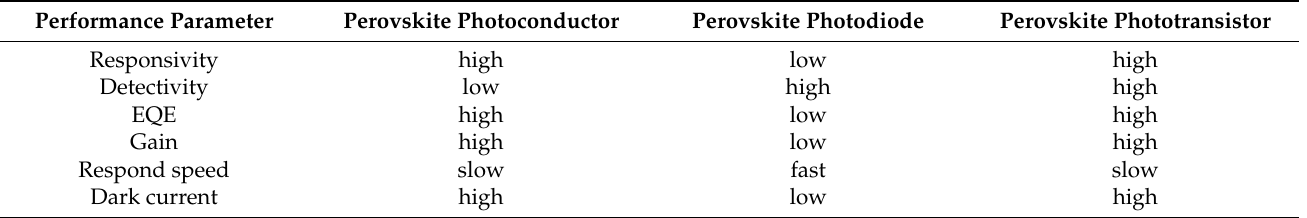
Table 1. Characteristics of performance parameters of perovskite photoconductors, photodiodes, and